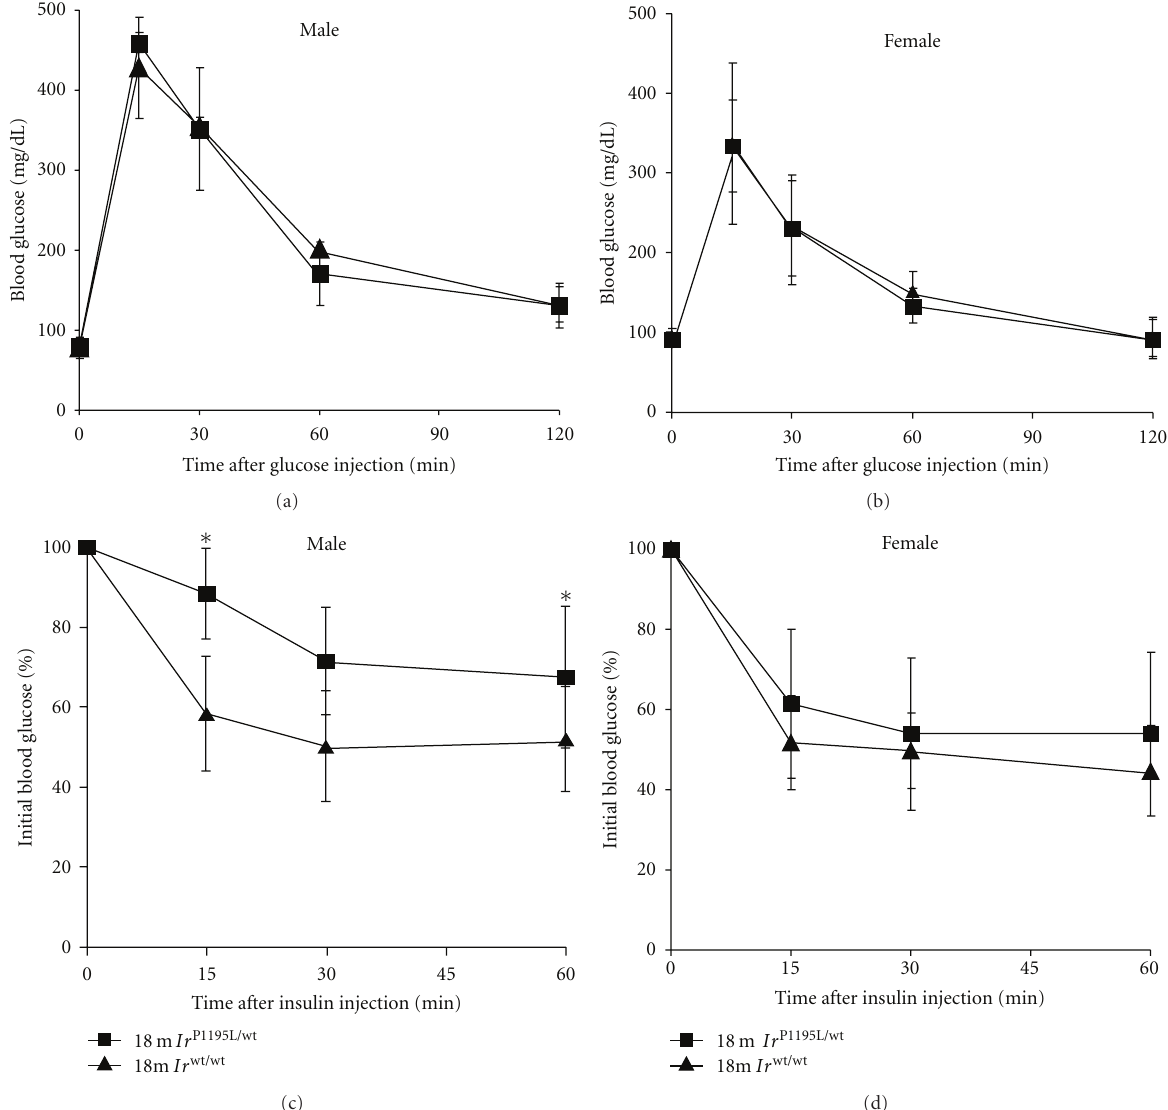
Figure 3: The results of the glucose and insulin tolerance tests in aged Ir P1195L / wt mice. (a, b) Glucose tolerance tests were performed on 18-month-old Ir wt / wt and Ir P1195L / wt mice ( n = 5 for each genotype). (c, d) Insulin tolerance tests were performed on 18-month-old Ir wt / wt and Ir P1195L / wt mice ( n = 5 in each genotype). ∗ P < 0 . 05 by Student’s t -